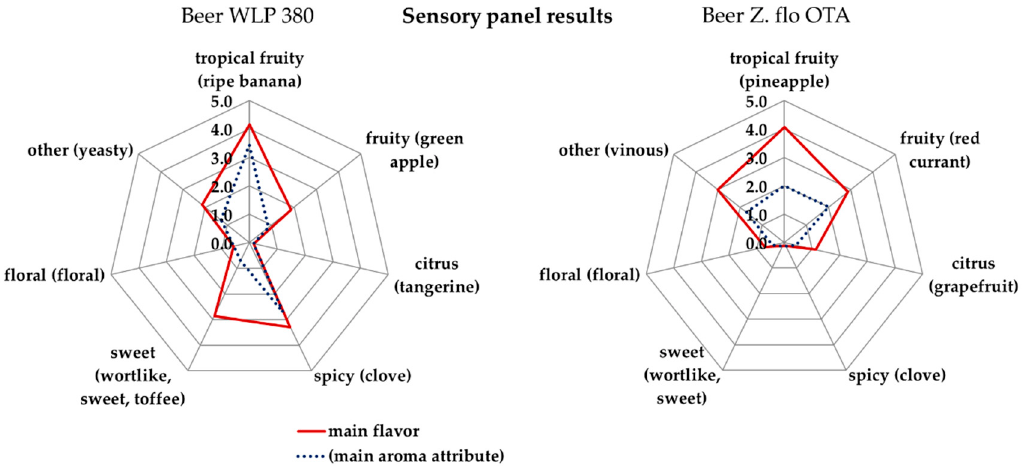
Figure 4. Comparison of the flavors grouped according to the main categories and the respective main aroma attribute for beer produced with the yeast strains S. cerevisiae WLP 380 ( left ) and Z. florentina Z. flo OTA ( right ).